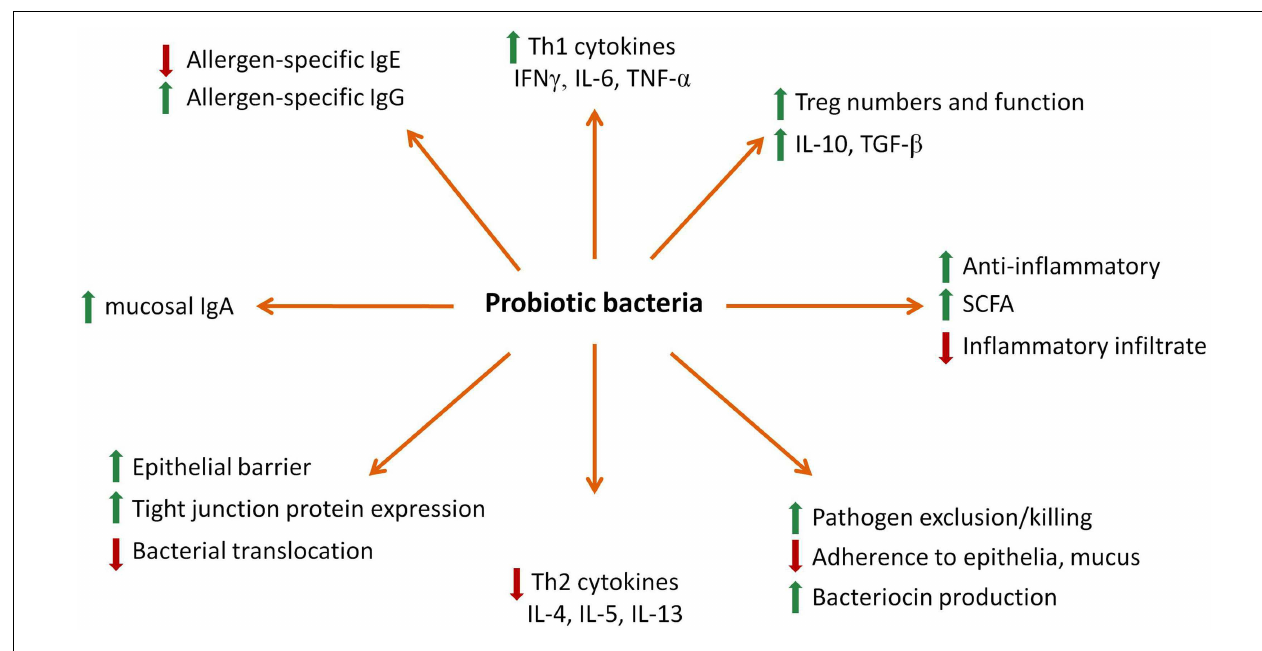
FIGURE 1 |A summary of probiotic biological